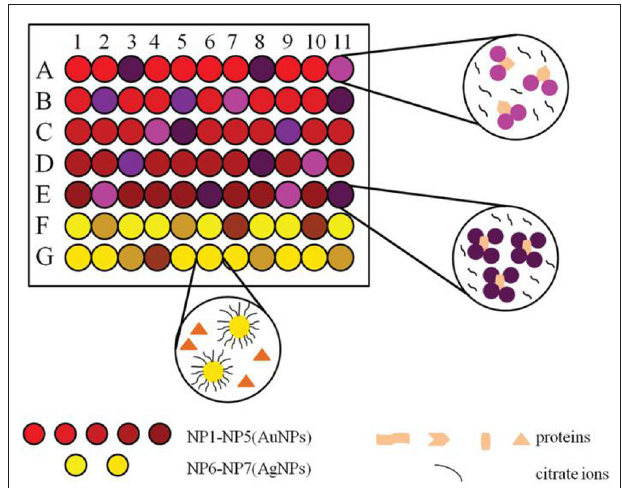
FIGURE 7 | Schematic representation of a sensor array based on seven noble metal nanoparticles for protein recognition. Reprinted from Zhang S. et al. (2015) with